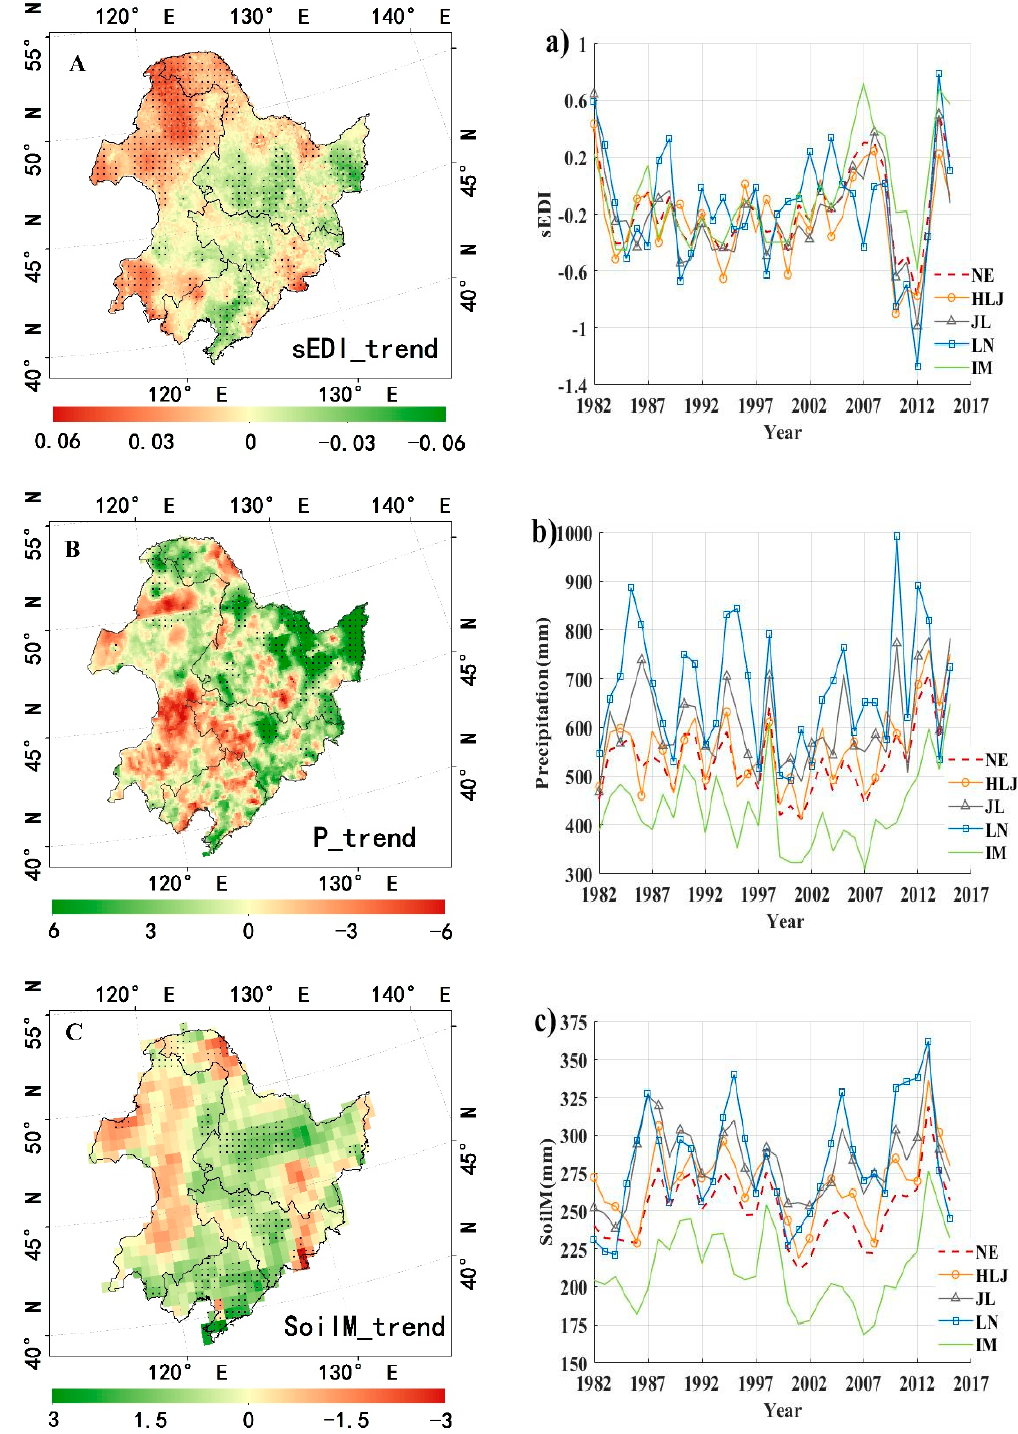
Figure 13. ( left ) Spatial patterns of multiyear trend of sEDI, P, and SoilM during 1982–2015 in Northeast China: ( A ) green indicates wetter and red indicates dryer; ( B ) the P_trend pattern is in units of mm / year; ( C ) the SoilM_trend pattern is in units of mm / year. The black solid dots refer to grids with 95% confidence. ( right ) The variation of average trend of ( a ) sEDI, ( b ) P, and ( c ) SoilM for di ff erent regions: the whole Northeast China (NE), Heilongjiang (HLJ), Jilin (JL), Liaoning (LN), and Part of Inner Mongolia (IM).